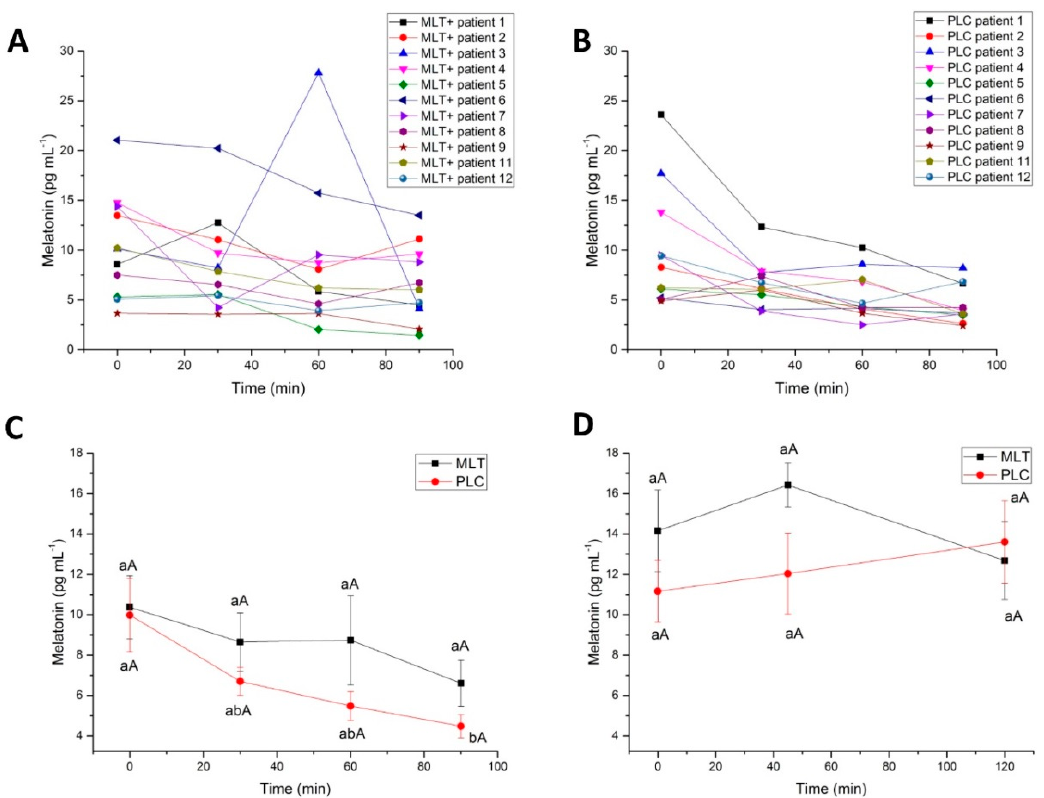
Figure 2. ( A , B ) Time-course of the serum melatonin levels in each of the healthy volunteers from 0 min to 90 min after administration of red wine ( A ) without melatonin (placebo, PLC) or ( B ) the same wine fortified with melatonin (MLT). ( C ) Time-course of the serum melatonin mean levels in healthy volunteers ( n = 11) from 0 min to 90 min after administration of red wine without melatonin (PLC) or the same wine fortified with melatonin (MLT). Error bars represent the standard error of the mean (SEM). Statistical analysis: Different lower case or capital letters indicate differences within group and between groups, respectively ( p ≤ 0.05, ANOVA, Tukey’s HSD test). ( D ) Time-course of the salivary melatonin mean levels in healthy volunteers ( n = 11) from 0 min to 120 min after administration of red wine without melatonin (PLC) or the same wine fortified with melatonin (MLT). Error bars represent the standard error of the mean (SEM). Statistical analysis: Different lower case or capital letters indicate differences within group and between groups, respectively ( p ≤ 0.05, ANOVA, Tukey’s HSD test).